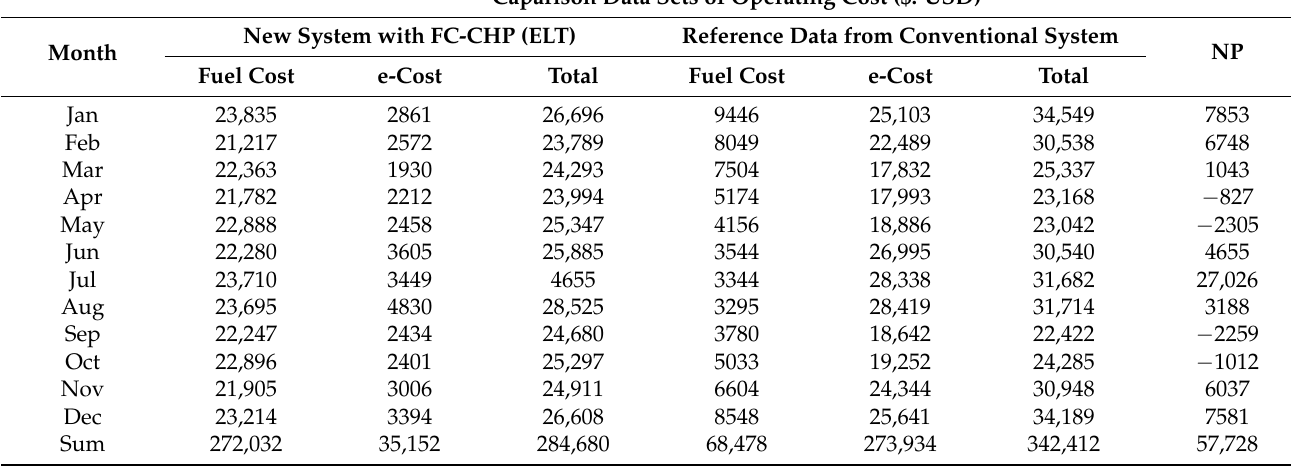
Table 6. Operating cost of the FC-CHP model under the ELT operating model and the net profit (NP), in comparison with the conventional energy supply system.